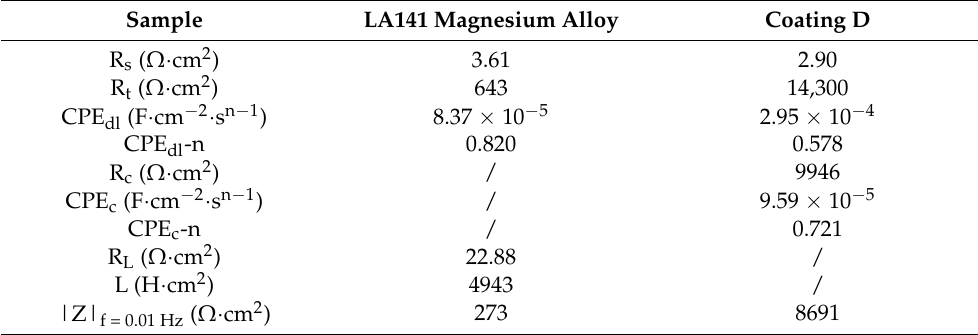
Figure 9. Electrochemical impedance behavior of Coating D and the LA141 magnesium alloy substrate: ( a ) Nyquist plots, ( b ) Bode impedance magnitude plots and Bode phase angle plots. ( c ) Fitted equivalent circuit model and schematic diagram of corrosion process of Coating D. ( d ) Fitted equivalent circuit model and schematic diagram of corrosion process of LA141 magnesium alloy. Table 3. EIS fitted results for Coating D and the bare LA141 magnesium alloy.